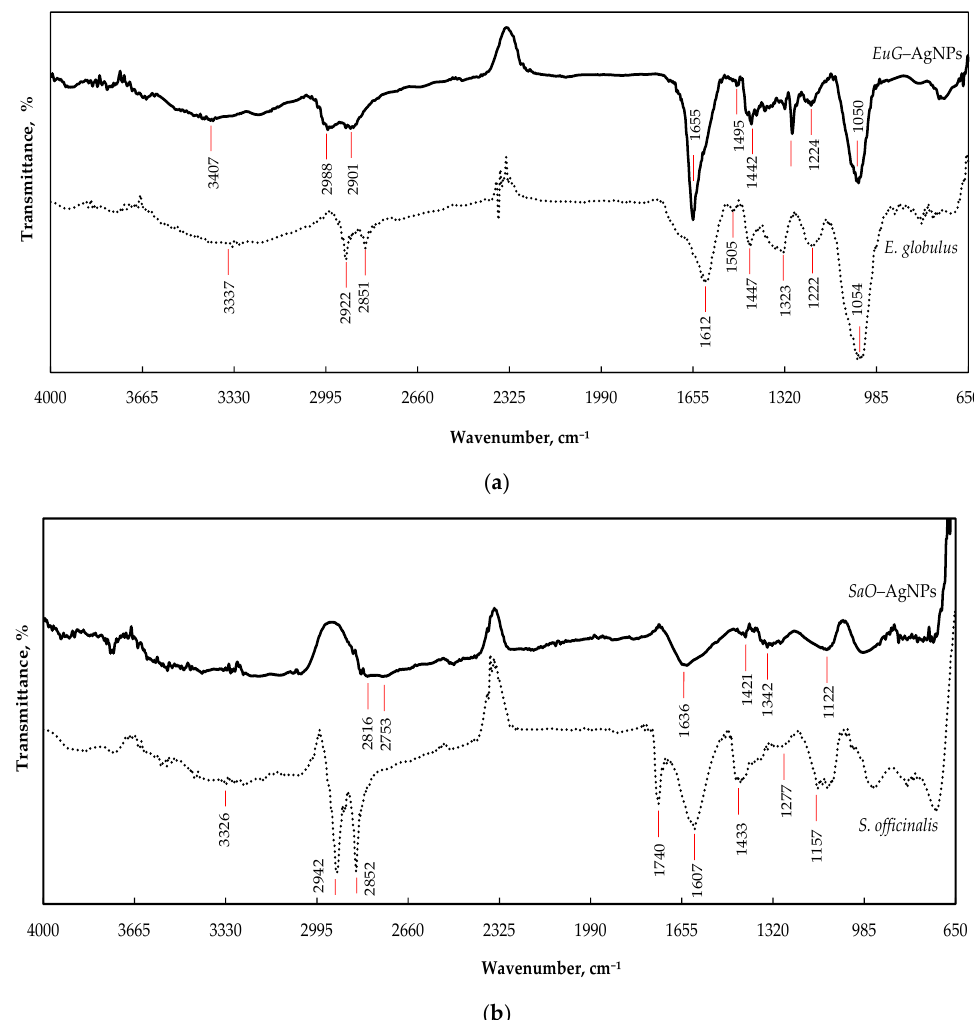
Figure 3. FTIR spectra of AgNPs synthesized by the reduction of AgNO 3 with the E. globulus ( a ) and S. officinalis ( b ) leaf extracts. S. officinalis ( b ) leaf